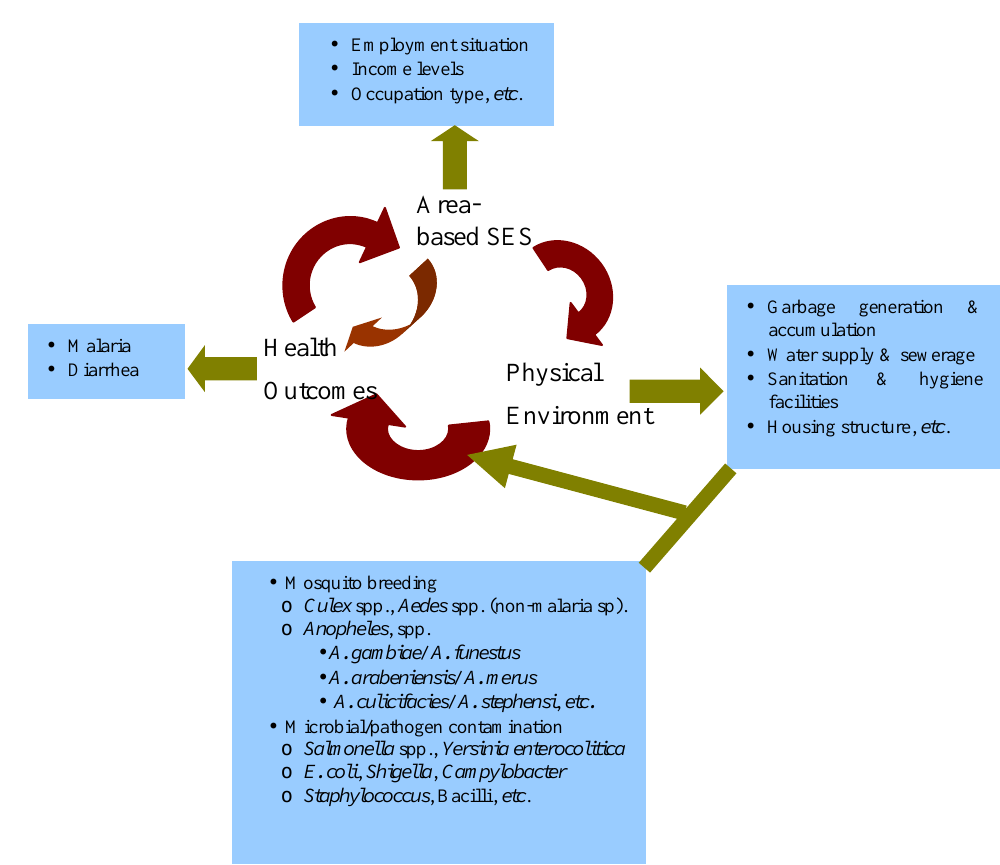
Figure 1. Interaction among Area-base SES, Environmental Quality and